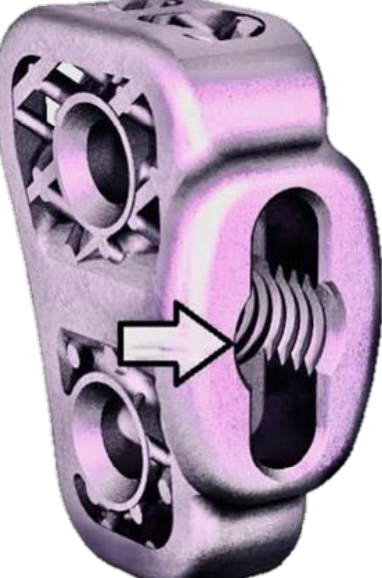
Figure 5. Image of the 6 mm TTA CF titanium implant. The end of the arrow points to a threaded hole on its medial longest edge for screwing the drill guide intraoperatively. The same threaded hole was used to fix the custom bar when performing biomechanical tests.